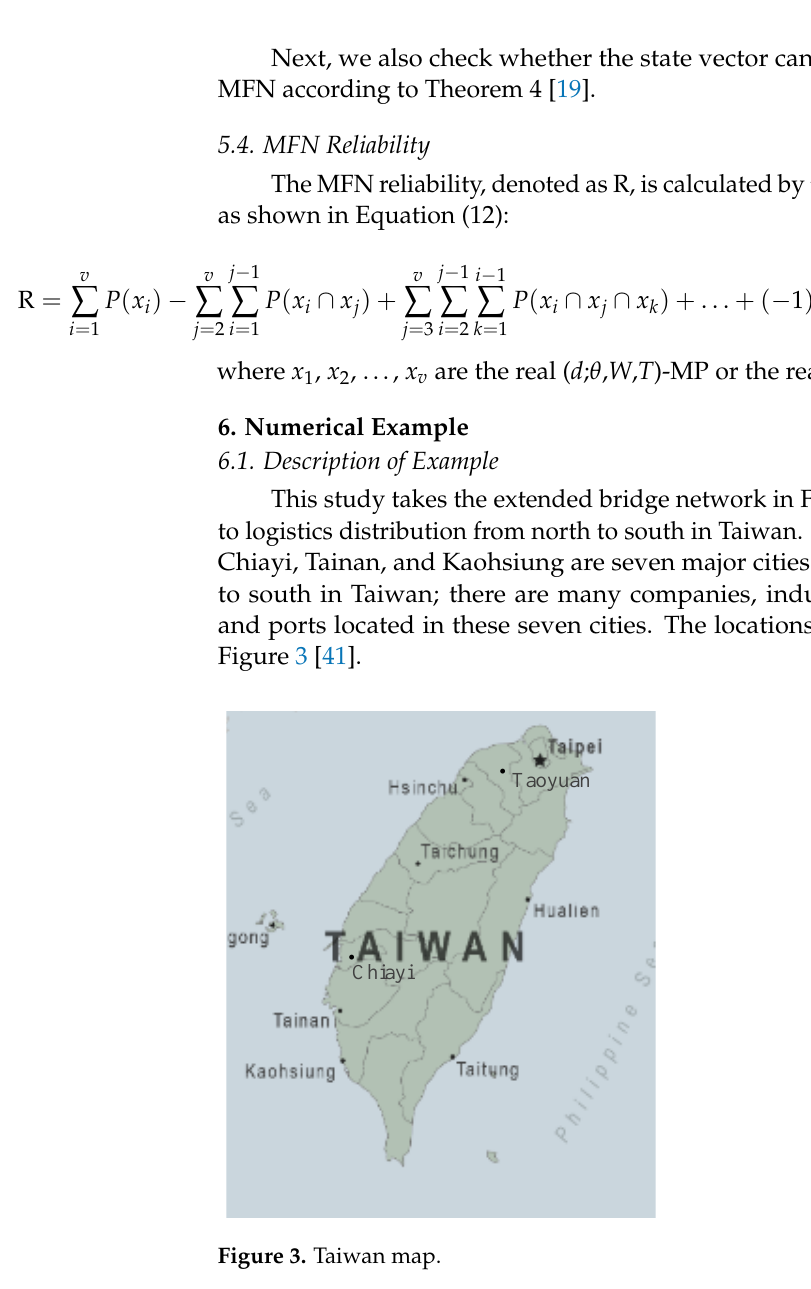
Figure 4. Directed MFN of goods shipped from northern Taiwan to the south.